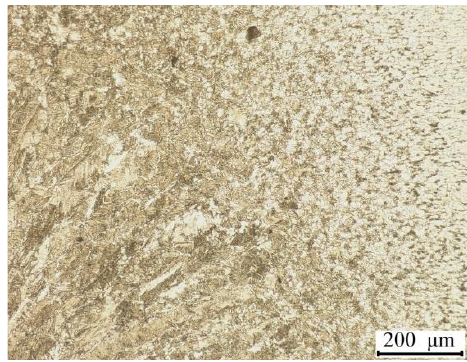
Figure 3. The cross-section of a welded sample.